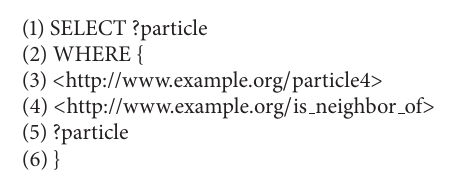
Algorithm 6: SPAQL query that returns particles in the neighbor- hood of